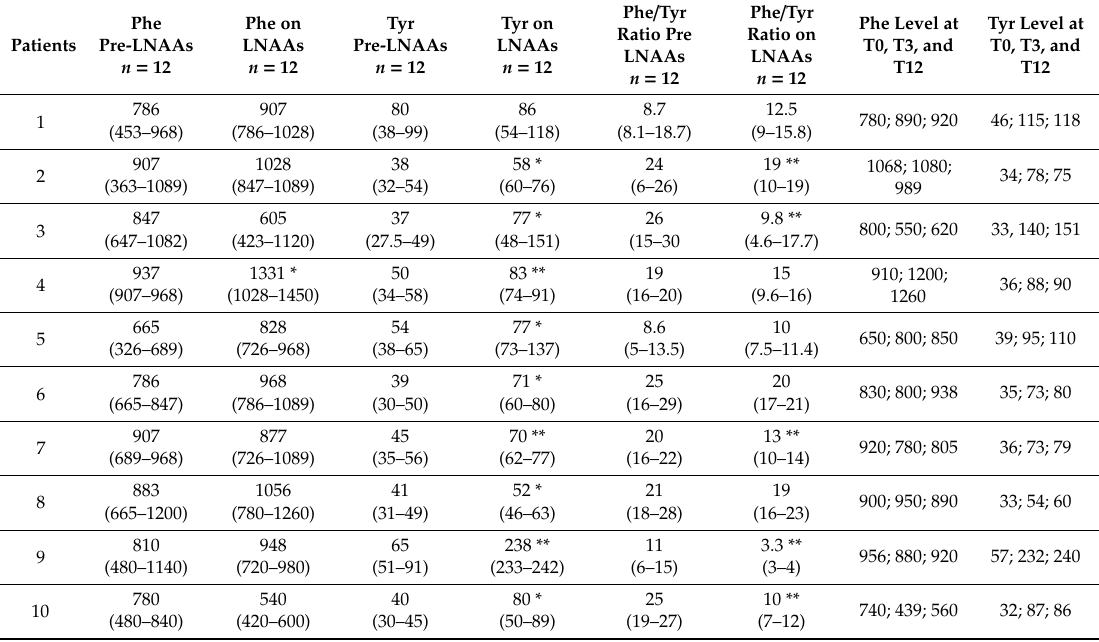
Table 3. Comparison of median plasma phenylalanine (Phe), Tyrosine (Tyr), and phenylalanine / Tyrosine (Phe / Tyr) ratio before and during large neutral amino acids (LNAAs)